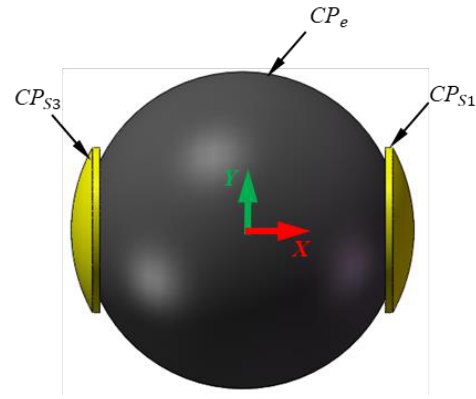
Figure 7. Simulation model of the spherical capacitive sensor.